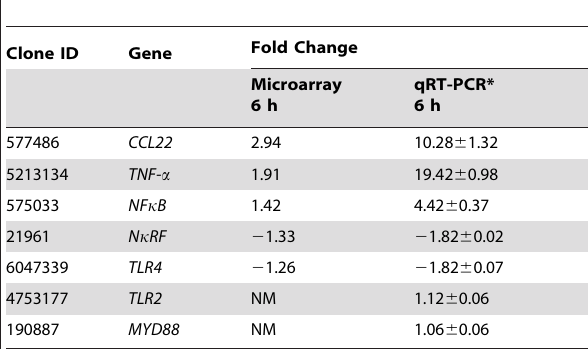
*Fold-change values were determined after normalization to Rps9 using the comparative threshold method. Values indicate mean fold change 6 SD of two independent experiments. NM: not significantly modulated, as shown by microarray.